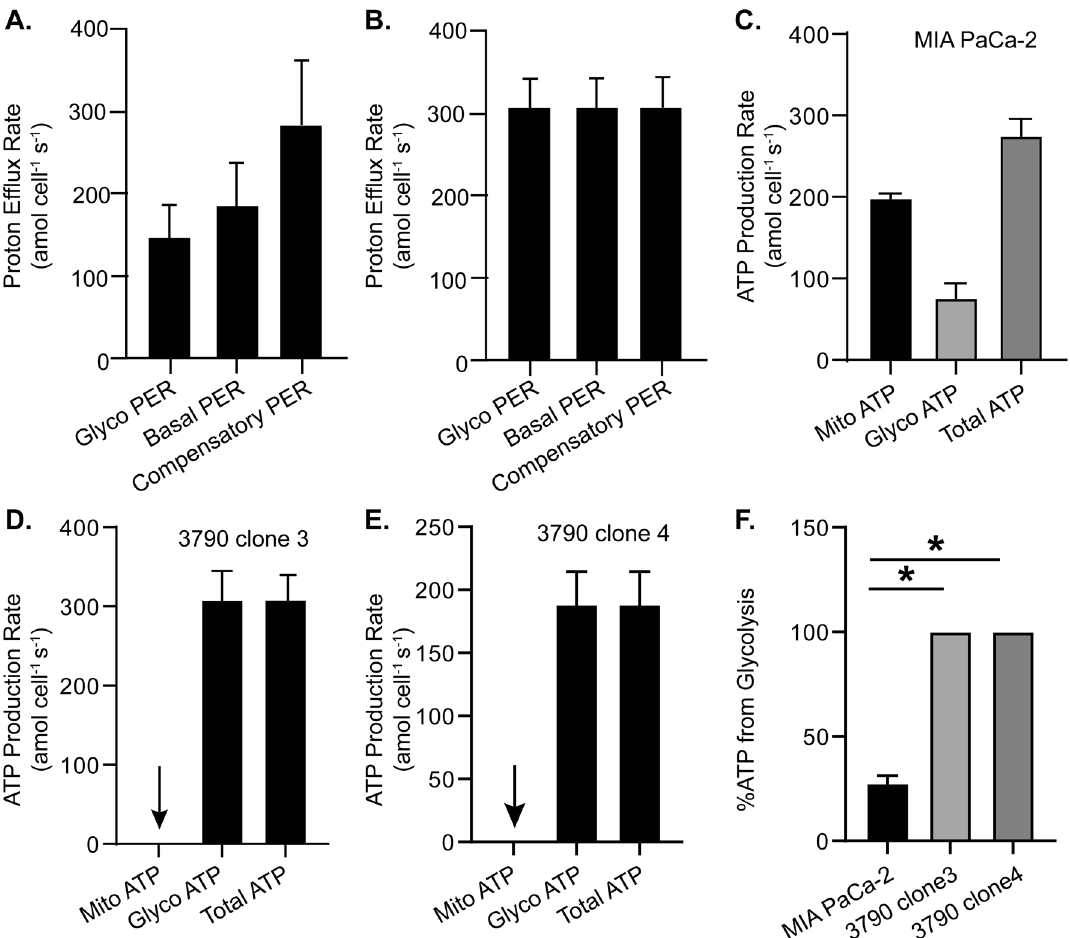
Figure 2. Glycolytic contribution to PER in MIA PaCa-2 and ρ 0 cells. MIA PaCa-2 and ρ 0 cells were seeded into a Seahorse 96-well XF Cell Culture Microplate. After 48 h, extracellular acidification rate (ECAR) and oxygen consumption rate (OCR) were measured. GlycoPER, basal PER and compensatory PER were calculated and normalized to cell number and expressed as amol cell −1 s −1 36 . ( A ) GlycoPER, basal PER, and compensatory PER of MIA PaCa-2 cells ( n = 3, mean ± SEM). ( B ) GlycoPER, basal PER and compensatory PER of 3790 clone 3 ( n = 3, mean ± SEM). ( C ) Contributions to the total rate of production of ATP from mitochondrial and glycolytic sources in MIA PaCa-2 cells ( n = 3, mean ± SEM). ( D ) The rates of production of ATP in the 3790 clone 3 demonstrates that 100% of ATP is derived from glycolytic sources ( n = 5, mean ± SEM) (arrow, no mitochondrial ATP production). ( E ) The rate of production of ATP in the 3790 clone 4 demonstrates that 100% of ATP is derived from glycolysis ( n = 5, mean ± SEM) (arrow, no mitochondrial ATP production). ( F ) % ATP from glycolysis demonstrates that in the MIA PaCa-2 cells 27 ± 4% ATP is derived from glycolytic sources while both ρ 0 clones rely 100% on glycolysis ( n = 3, mean ± SEM; * p < 0.05, unpaired t